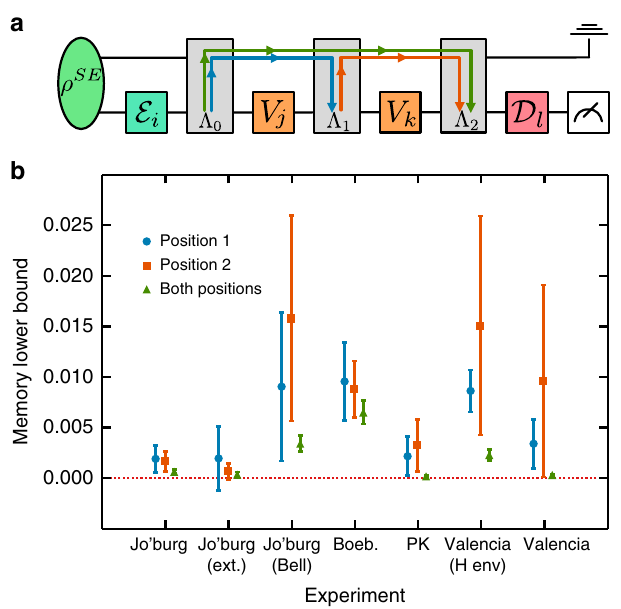
Fig. 3 Memory size and structure. a The circuit depicting the process tensor. Quantum information can travel in and out of the system across one or many operations. Each gate is a place-holder for a larger set. Each V i is an arbitrary unitary operation that need not belong to the set U . b The maximum CMI, which is a conservative lower bound for non-Markovian memory, through R for each process tensor experiment, with 95% con fi dence intervals. This shows statistically signi fi cant non-zero memory in the device, which shows consistency in the timescale and the environmental interactions present.